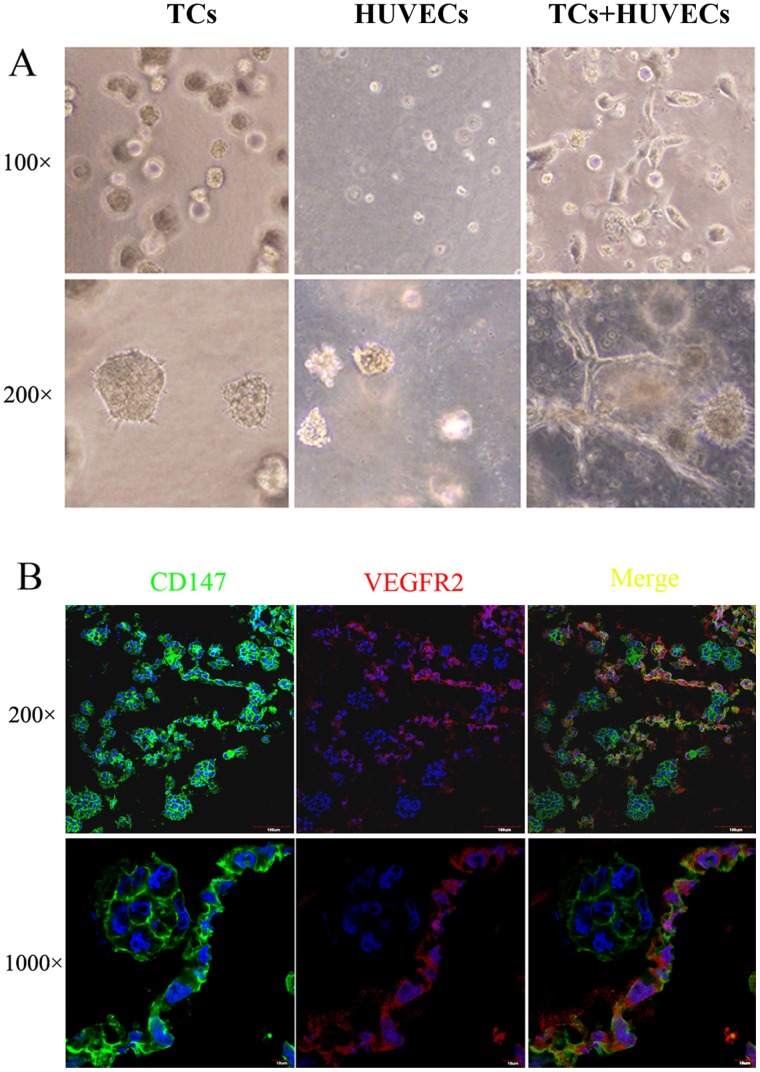
Morphological change of SMMC-7721 cells and HUVECs in a 3D co-culture model.(A) SMMC-7721 cells and HUVECs were seeded and cultured in Matrigel. Morphogenesis was observed by using an inverted phase-contrast microscope. (B) These 3D-cultured cell sheets were fixed and cut into sections which were stained with anti CD147 (green) and KDR/Flk (red) antibodies, and DAPI (blue), respectively, and observed using a laser scanning confocal microscope.